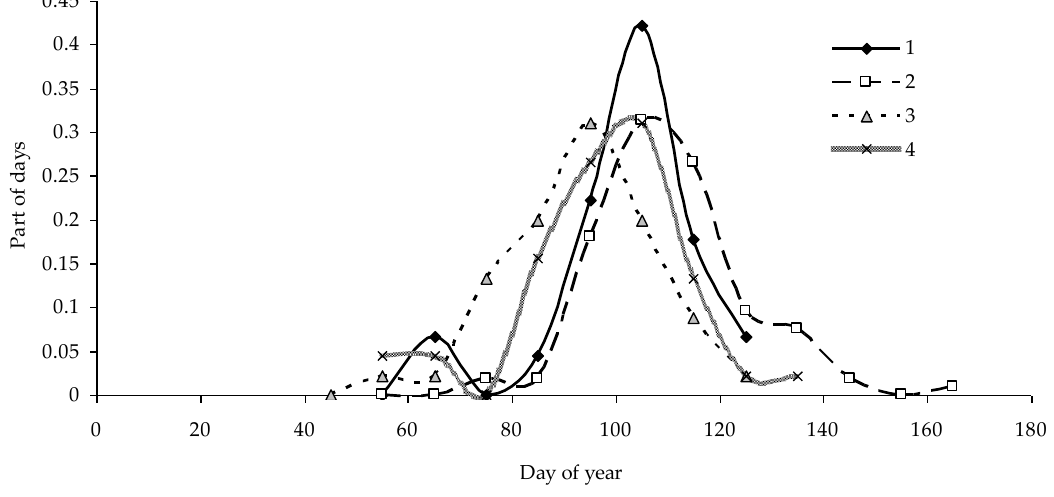
Figure 8. SOS distribution functions for the period between 2003 and 2017. ( 1 ) meadow, ( 2 ) steppe, ( 3 ) deciduous forest ( Betula pendula Roth, Pinus sylvestris L.), ( 4 ) coniferous forest ( Abies sibirica Ledeb., Pinus sylvestris L.).